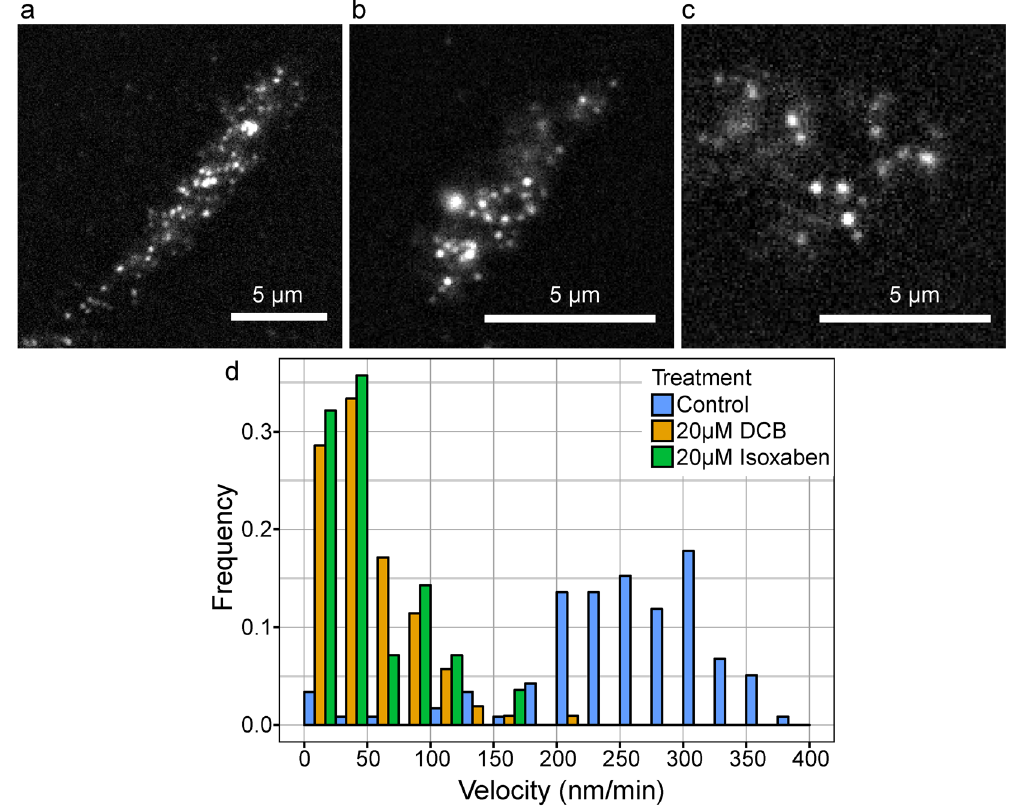
Figure 5. DCB and isoxaben inhibit mEGFP-PpCESA8 particle velocity, but do not affect particle density at the cell surface. ( a ) Control protonemal cell treated with 0.05% ethanol. Mean CSC density = 0.20 ± 0.09 (SD) particles/ μ m 2 , n = 11 time-lapses. ( b ) Protonemal cell treated with 20 μ M DCB. Mean CSC density 0.15 ± 0.11 particles/ μ m 2 , n = 5 time-lapses. ( c ) Protonemal cell treated with 20 μ M isoxaben. Mean CSC density 0.07 ± 0.09 (particles/ μ m 2 ), n = 5 time-lapses. Scale bars = 5 μ m. ( d ) Velocity distribution of mEGFP-PpCESA8 particles pooled from 21 time lapses. Mean velocities ± standard deviations in nm/min were: 253 ± 79 (Control); 47 ± 38 (20 μ M DCB); and 42 ± 40 (20 μ M